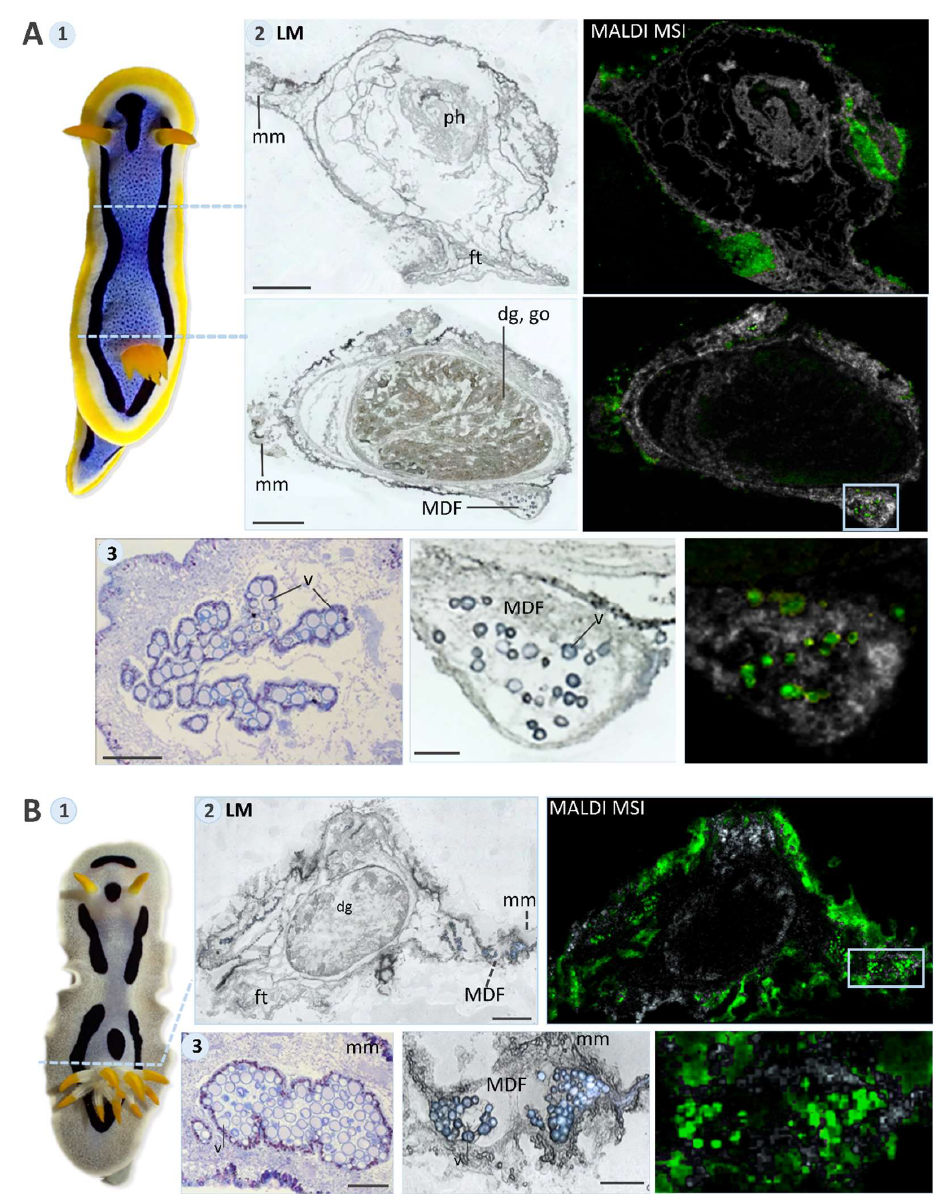
Figure 5. Comparison of optical and MALDI mass spectrometry images, revealing the distribution of LatA (green) in ( A ) Chromodoris annae and ( B ) Chromodoris dianae . ( A1 ) Dorsal overview of a Chromodoris annae specimen. ( A2 ) Overview of the anterior and middle cross-sections (20 µm, dotted lines) of C. annae by light microscopy and MALDI MSI, showing the distribution of LatA ( m/z 444.1813 [M + Na] + , 10 µm/pixel) in green. Square indicating MDF, which is shown as a close-up in: ( A3 ) Close-up view of a C. annae MDF, from left to right: histological section from another specimen, optical and MALDI image. ( B1 ) Dorsal overview of a Chromodoris dianae specimen. ( B2 ) Overview of the posterior cross-section (20 µm, dotted line) of C. dianae by light microscopy and MALDI MSI, showing the distribution of LatA ( m/z 444.1813 [M + Na] + , 10 µm/pixel) in green. Square indicating MDF, which is shown as close-up in: ( B3 ) Close-up view of a C. dianae MDF, from left to right: histological section (from another specimen), optical and MALDI image. Abbreviations: dg , digestive gland; ft , foot; gc , gill circle; go , gonads; LM , light microscopy; MALDI MSI , matrix-assisted laser desorption/ionization mass spectrometry imaging; MDF , mantle dermal formation; mm , mantle margin; ph , pharynx; v , vacuole. Scale bars: A/B2 = 1000 µm; A/B3 = 200 µm.